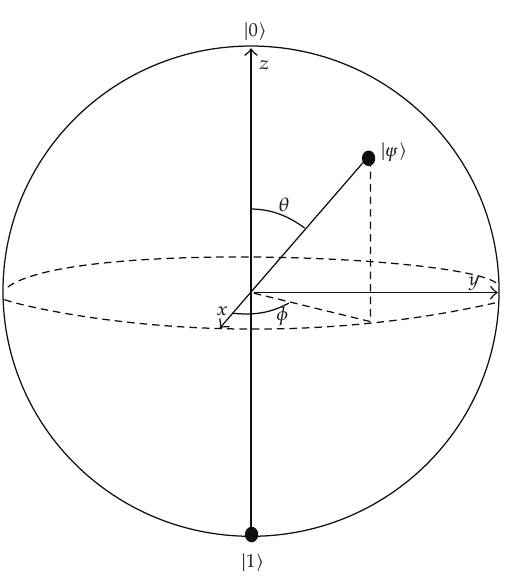
Figure 1: The Bloch Sphere—a geometric representation of the Hilbert space of a qubit. Any pure qubit state, modulo a global phase, can be represented by a point on the surface of the sphere given by | Ψ (cid:2) (cid:7) cos θ | 0 (cid:2) (cid:8) e ıφ sin θ | 1 (cid:2) .